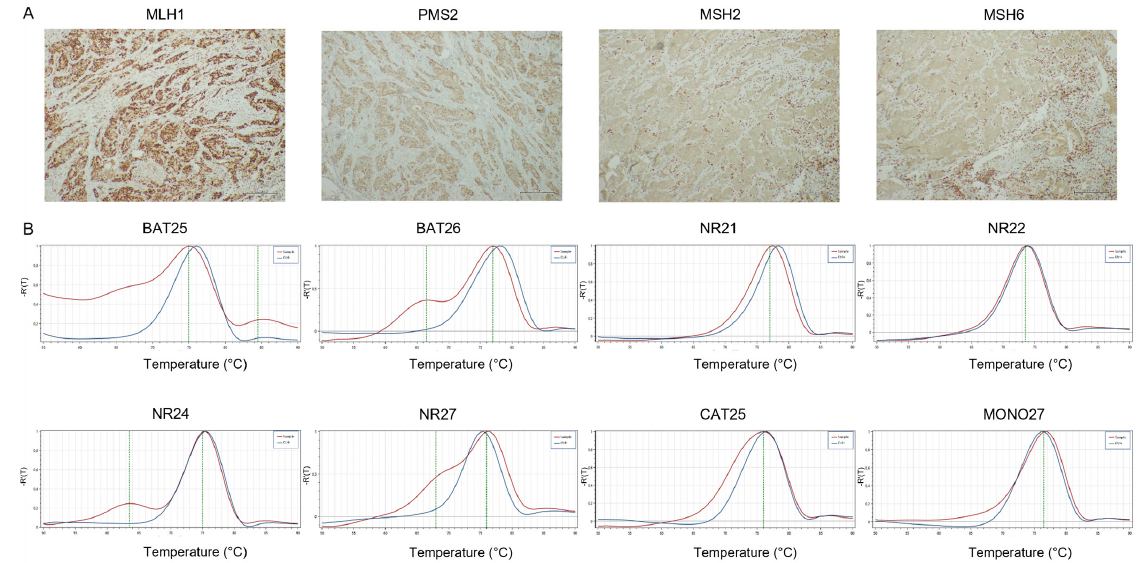
Figure 2. Representative results of CRC case showing dMMR-IHC and MSI-H by PCR. ( A ) MMR-IHC results: intact expression of MLH1 and PMS2 in tumor cells (original magnification 10×); loss expression of MSH2 and MSH6 in tumor cells with positive internal control (original magnification 10×). ( B ) MSI-PCR results: stability of NR21, NR22 and MONO27; instability of BAT25, BAT26, NR21, NR24, NR27 and CAT25 (red lines indicate samples while blue lines indicate MSS controls).